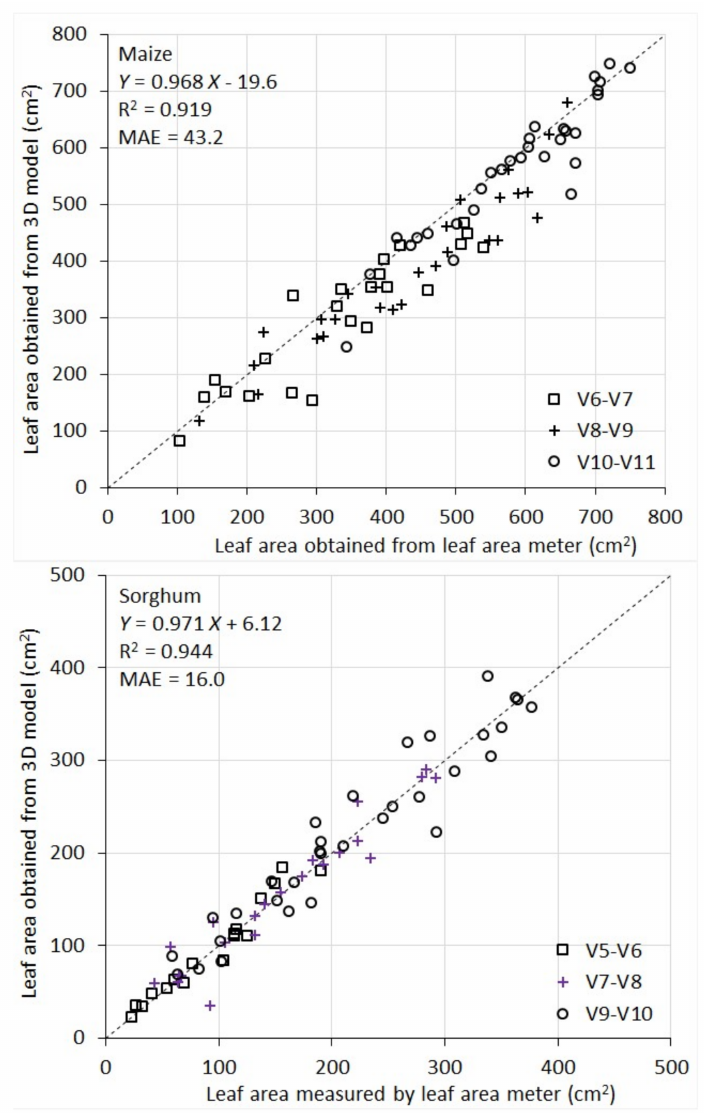
Figure 6. Scatterplot of individual leaf areas of 10 maize and 10 sorghum plants measured by the leaf area meter vs. obtained from 3D plant models. Different legends indicate different growth